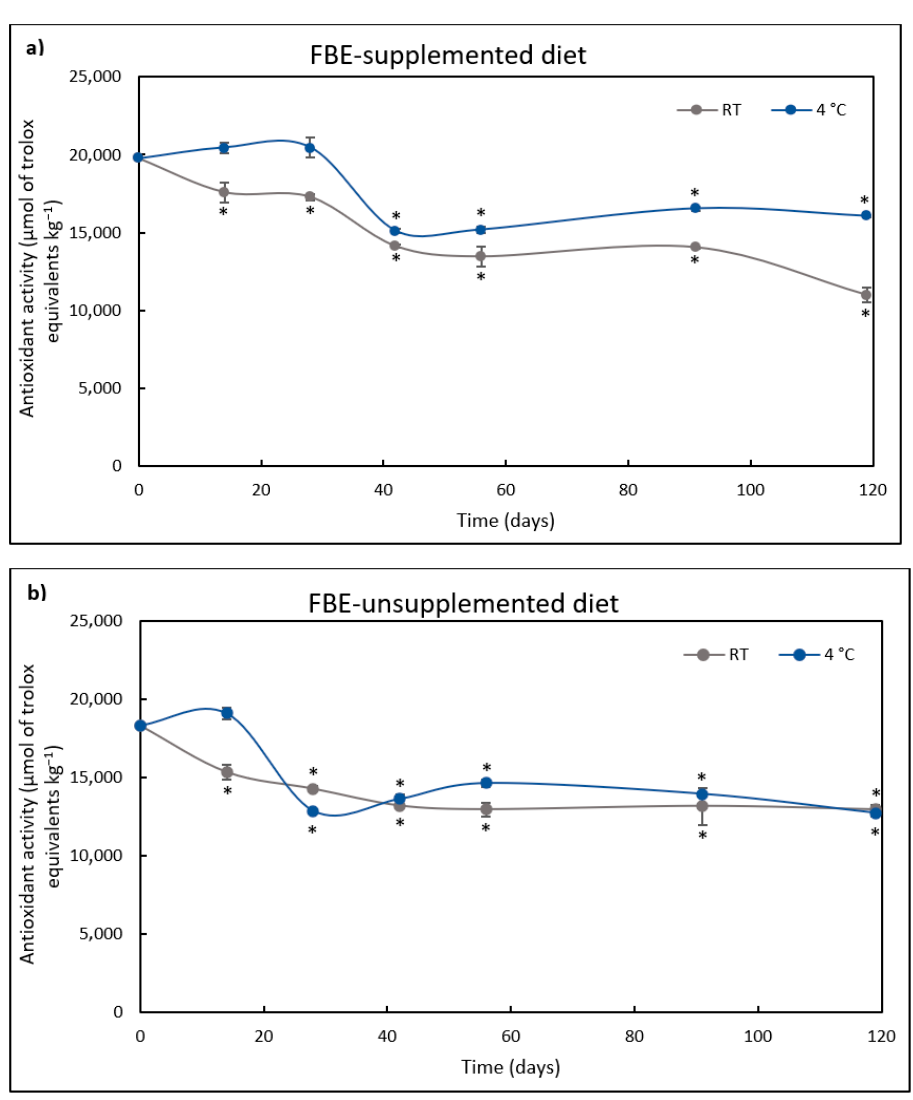
Figure 3. Antioxidant activity (µmol/kg) of FBE-supplemented diet ( a ) over storage time (days) at room temperature (RT) and 4 °C. The results represent the average of three independent. Antioxi- dant activity (µmol/kg) of FBE-unsupplemented diet ( b ) over storage time (days) at room temperature (RT) and 4 °C. The results represent the average of three independent experiments and the error bars represent SD. The asterisk denotes a significant difference ( p < 0.05) from the initial antioxidant activity.